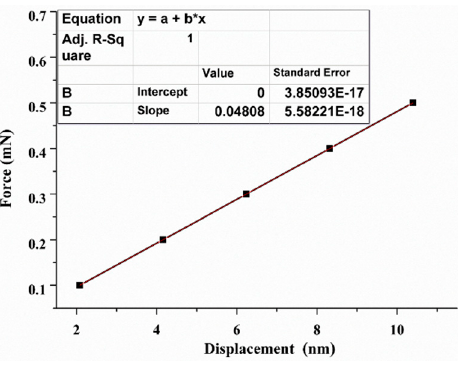
Figure 5. Displacement curve with an increasing force for calculating the spring constant k of a bare QTF.